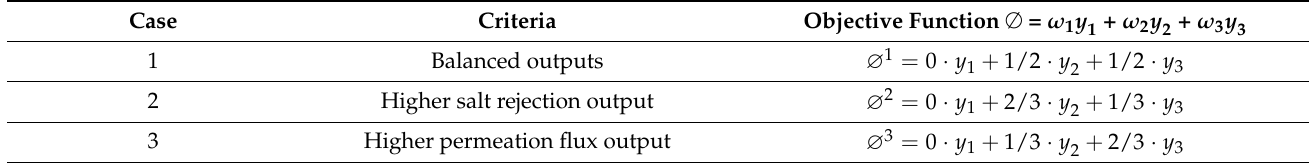
Table 6. Criteria to target different